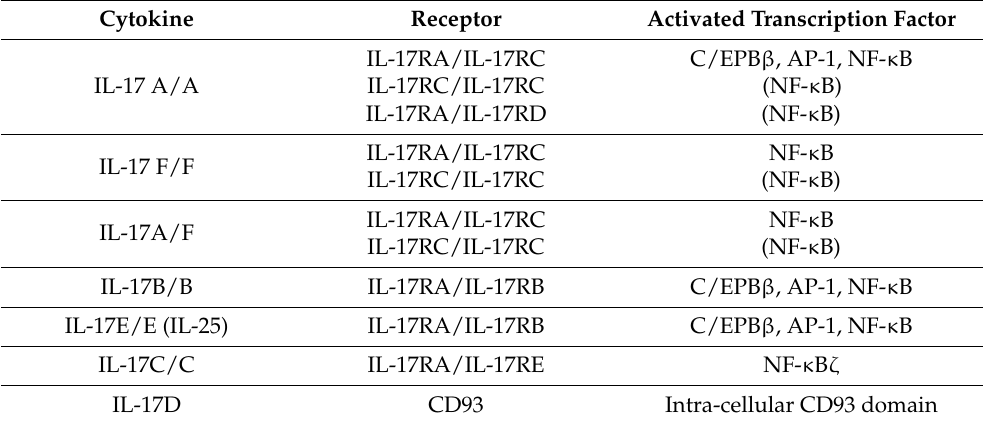
Table 1. The interleukin-17 family members, receptors, and target transcription factors. Cytokine Receptor Activated Transcription Factor IL-17 A/A